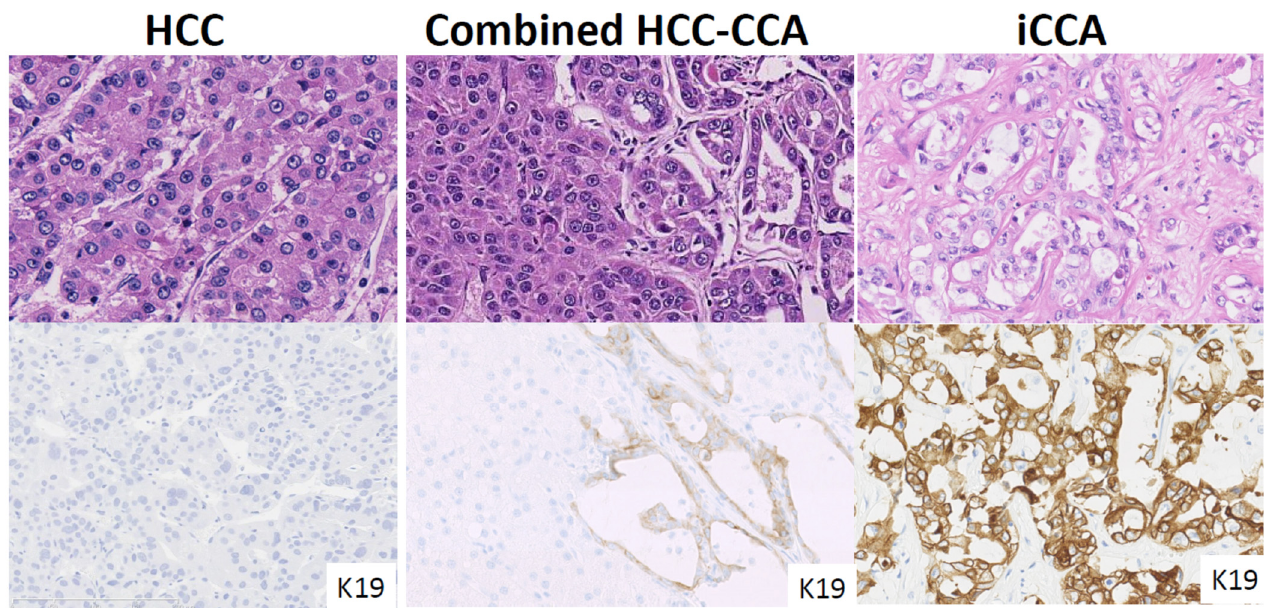
Figure 1. Pathological features of hepatocellular carcinoma (HCC), intrahepatic cholangiocarcinoma (iCCA) large duct type, and combined HCC-CCA. HCC shows a trabecular growth pattern, whereas large duct type iCCA shows a glandular structure with mucin production. Combined HCC-CCA shows both HCC and iCCA features. Keratin 19 staining shows diffuse and intense cytoplasmic positivity in iCCA, but negative in HCC. Combined HCC-CCA shows K19 weak expression in the cholangiocytic differentiated area.